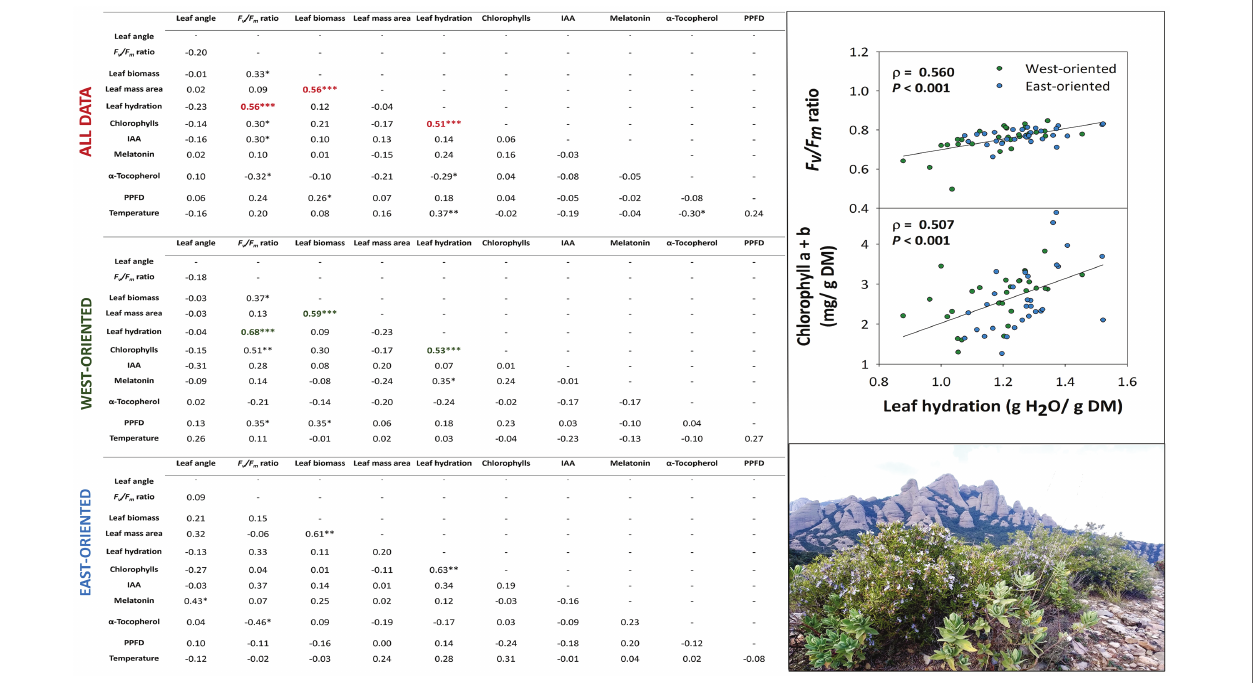
FIGURE 7 | Relationship between all measured parameters in C. albidus from a natural population in the Natural Park of the Montserrat Mountains. Tables show the results of the Spearman’s rank correlation analyses (including the correlation coefficient, ρ , and p indicated with asterisks) for all data pooled together, for West- oriented individuals only and for East-oriented individuals only. All correlations were considered statistically significant at p ≤ 0.05, with one, two, and three asterisks indicating p below 0.05, 0.01, and 0.001, respectively. Correlations with a correlation coefficient, ρ ≥ 0.50, are shown in red, green, and blue for all data pooled together, West-oriented individuals, and East-oriented individuals, respectively. The plots in the right side of the figure show a graphical representation of the most biologically significant correlations. IAA, indole-3-acetic acid; PPFD, photosynthetic photon flux